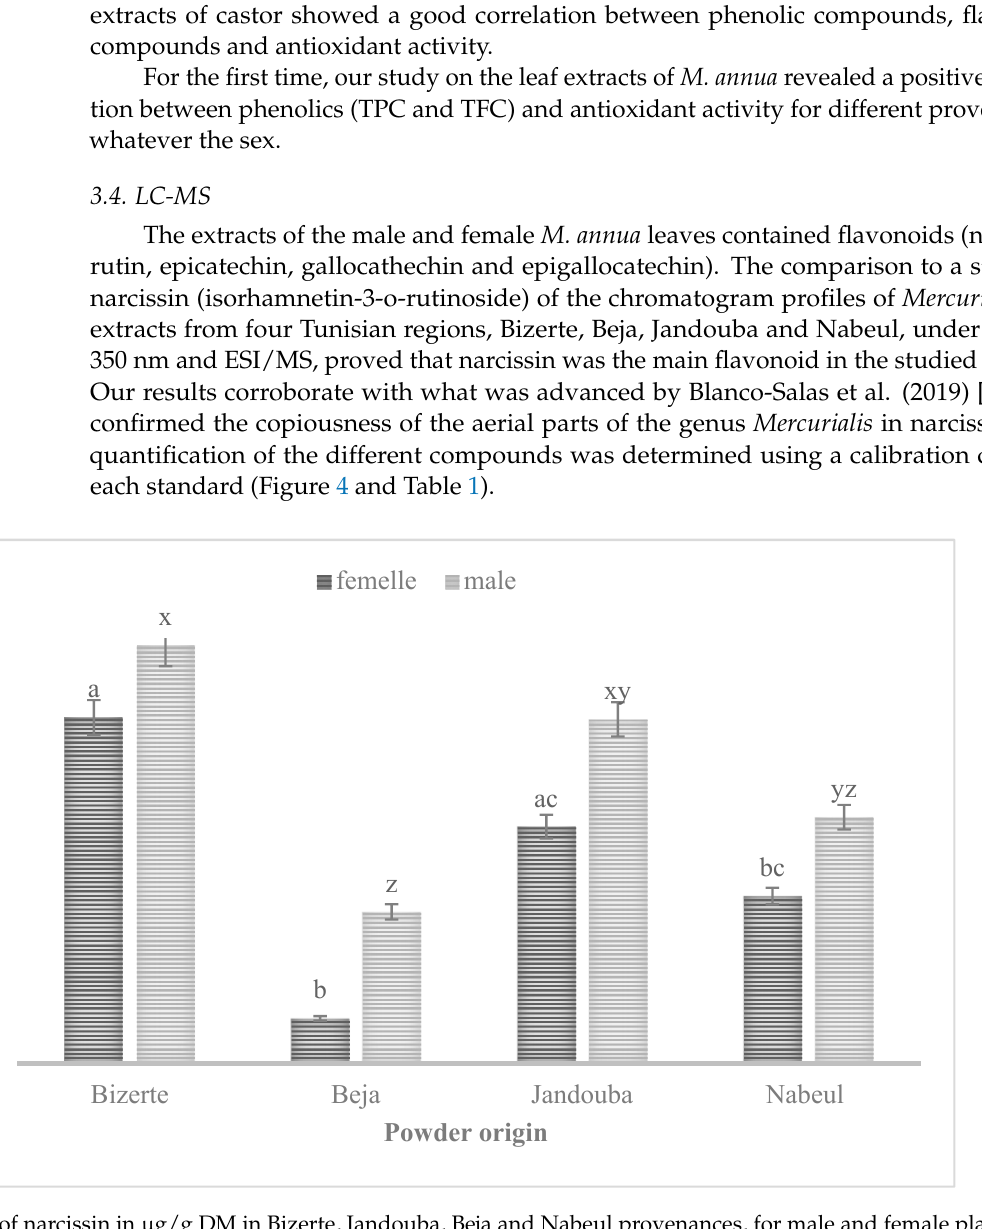
Figure 4. Amount of narcissin in μ g/g DM in Bizerte, Jandouba, Beja and Nabeul provenances, for male and female plants. Results of the Bonferroni test are significantly different at p < 0.05. Marked columns not linked by the same letter are significantly different at p < 0.05, and each data point is represented by the average of three repetitions ± SD. Table 1. Concentration ( µ g/g DM) of flavanol compounds identified in the M . annua leaves for male and female plants of four Tunisian provenances. Amount of Flavonol in µg/g DM RT (min) Male Plant Bizerte Beja Values shown are mean ± SD ( n =